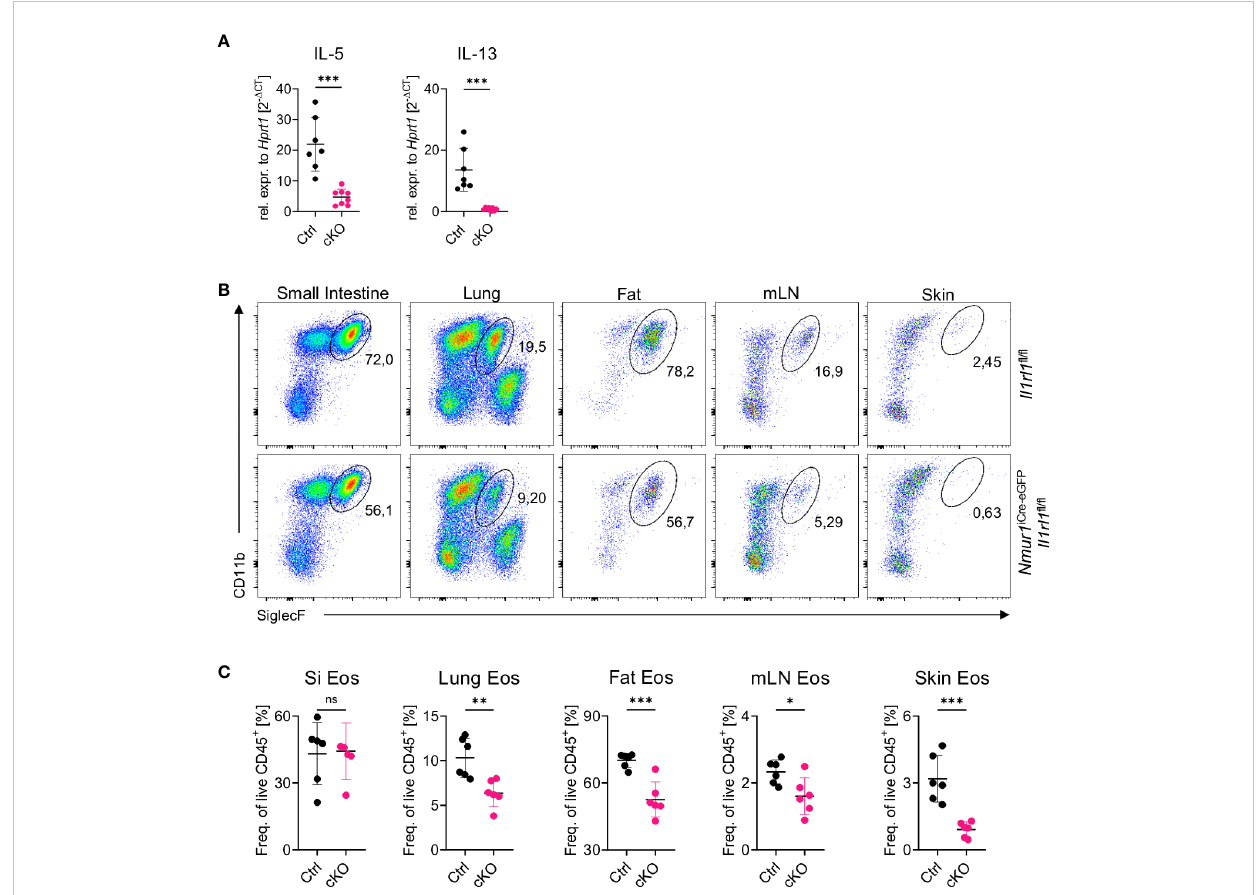
FIGURE 4 Loss of constant ST2 signaling results in reduced eosinophil counts. (A) , Relative expression of the cytokine IL-5 and IL-13 of Il1rl1 fl ox/ fl ox (Ctrl) and Nmur1 iCre-eGFP Il1rl1 fl ox/ fl ox (cKO) mice from the lung at steady state. (B) , Flow cytometric plots of eosinophils from Il1rl1 fl ox/ fl ox and Nmur1 iCre-eGFP Il1rl1 fl ox/ fl ox mice across different organs in steady state. Eosinophils were gated on live CD45 + Lin - (CD3, CD5, CD19), CD11b + and SiglecF + . (C) , Quanti fi cation of (B) in Il1rl1 fl ox/ fl ox (Ctrl) and Nmur1 iCre-eGFP Il1rl1 fl ox/ fl ox (cKO) mice across different organs in steady state. For (A, C) : Each symbol represents data from one mouse, data are representative of two experiments with fi ve to seven mice per group. Mean +/- SD, student ’ s t-Test. ns, not signi fi cant, *p < 0.05, **p < 0.01, ***p <